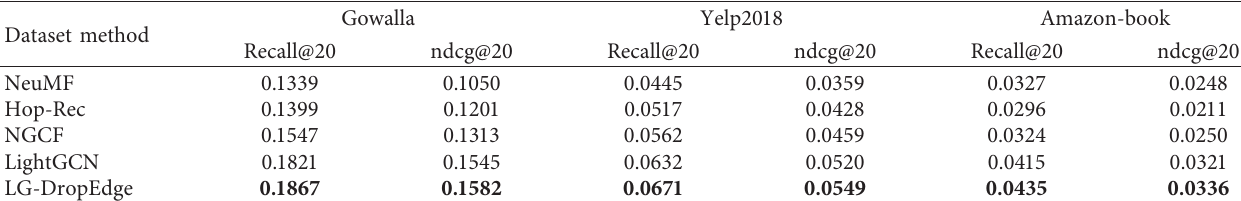
Table 3: Overall performance comparison.